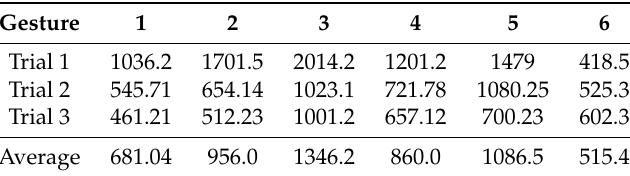
Table 1. Total error, E T ( ◦ s), for each gesture and its average value when there is no compensator on the goniometric glove.